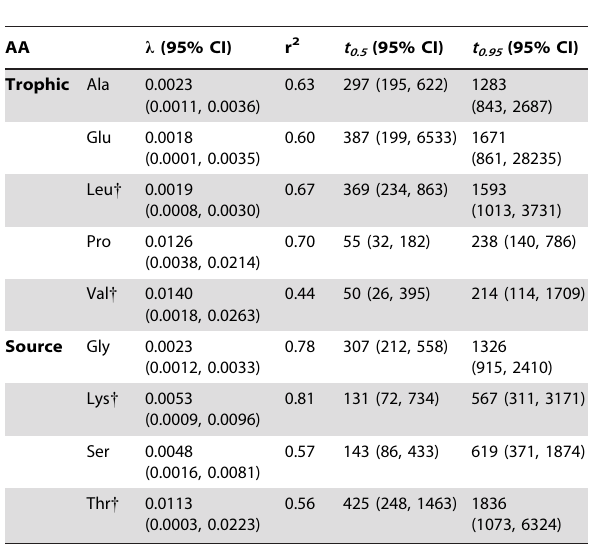
Table 3. Time-based 15 N amino acid incorporation rate, half- life (t 0.5 ) and steady state (t 0.95 ) estimates, in days, with 95% confidence intervals calculated from an exponential fit model for Pacific bluefin tuna ( Thunnus orientalis